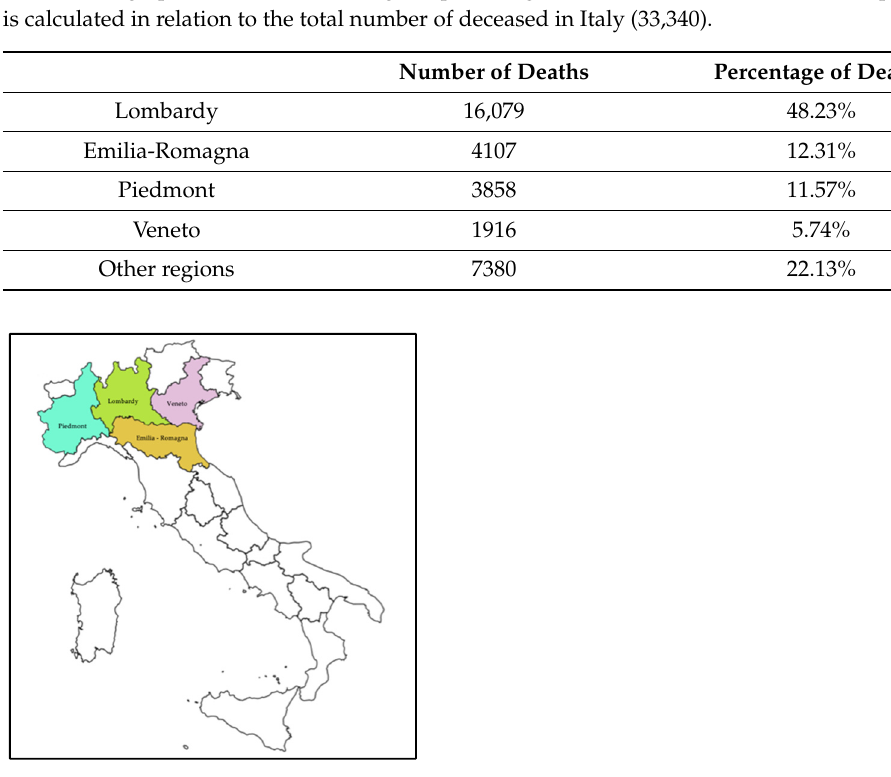
Figure 1. The most affected region during the first